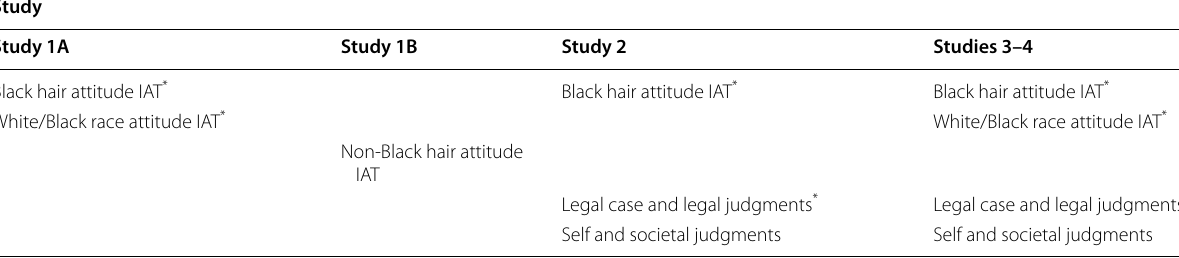
Each unique measure is presented in a separate row, with the order from top to bottom representing the order of the measures in each study. The order of the measures with the same number of asterisks within each study was counterbalanced. Specifically, In Studies 3 and 4, the Black hair IAT attitude IAT and the White/ black race attitude IAT were always administered after each other in counterbalanced order. The legal case and legal judgments were administered either before or after both IATs